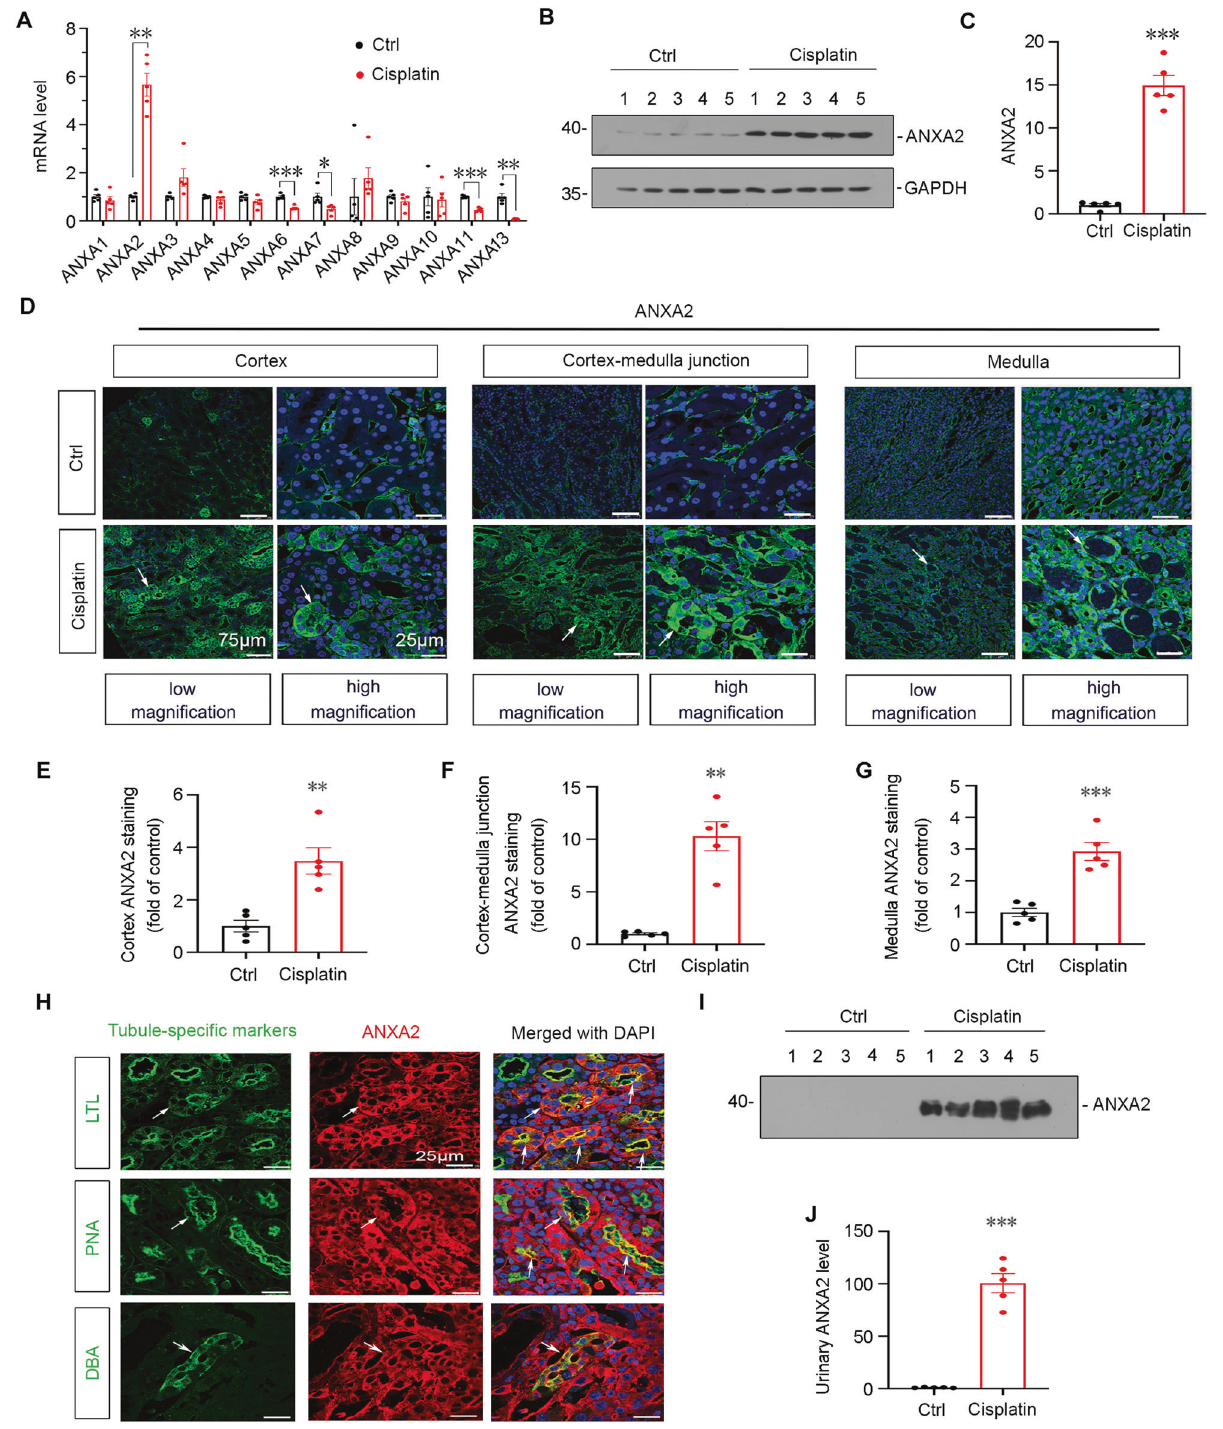
Fig. 1 ANXA2 is upregulated in cisplatin-induced AKI mice. A Quantitative data shows the relative expression of different ANXA family members in cisplatin-treated mice or control mice. * P < 0.05, ** P < 0.01, *** P < 0.001 versus Ctrl group ( n = 5). B , C Western blot analysis shows the expression of ANXA2 in two groups. *** P < 0.001 versus Ctrl ( n = 5). D Immuno fl uorescence staining demonstrates the expression of ANXA2 is upregulated across different sections in AKI-affected kidney. White arrows indicate positive staining. Scale bars, 75 μ m (low magni fi cation); 25 μ m (high magni fi cation). E – G Quanti fi cation of positive staining. ** P < 0.01, *** P < 0.001 versus Ctrl group ( n = 5). H Co- localization of ANXA2 (red) with LTL (green, a marker for proximal renal tubule), PNA (green, a marker for distal renal tubule) and DBA (green, a marker for collecting duct) are shown. Results show ANXA2 is largely expressed in proximal and distal tubules, but localizes in collecting ducts to a less extent. White arrows indicate positive staining. Scale bars, 25 μ m. I, J Western blotting shows urinary ANXA2 expression. Mouse urine samples were collected and tested by western blotting. The urinary ANXA2 expression was quanti fi ed by normalizing to Urinary creatinine. *** P < 0.001 versus Ctrl ( n = 5). Abbreviations: ANXA2 Annexin A2, Ctrl control.